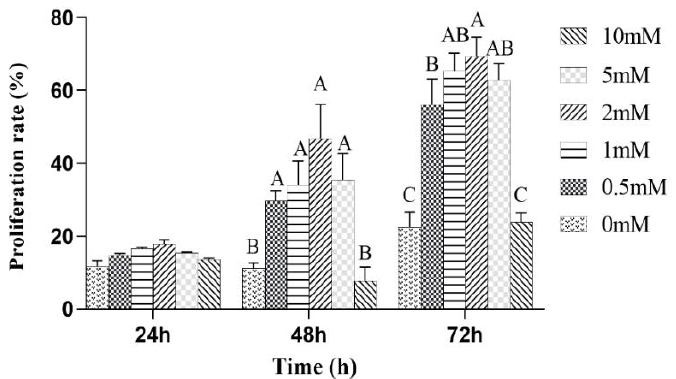
Figure 4. The effect of L-leu on the activity of equine SCs. The values with different small letter superscripts mean significant difference ( p < 0.05), and with different capital letter superscripts mean significant difference ( p < 0.01), while with the same or letter superscripts mean no significant dif- ference ( p > 0.05).